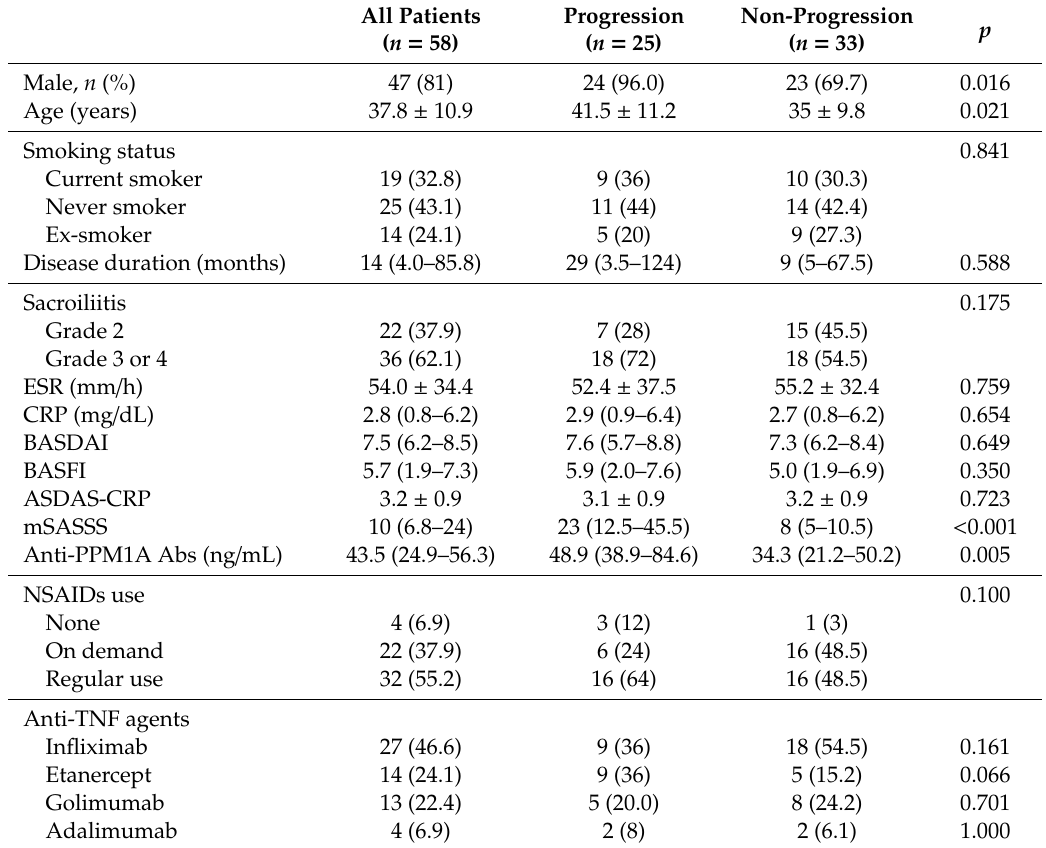
Table 1. Baseline characteristics of patients before treatment with anti-TNF